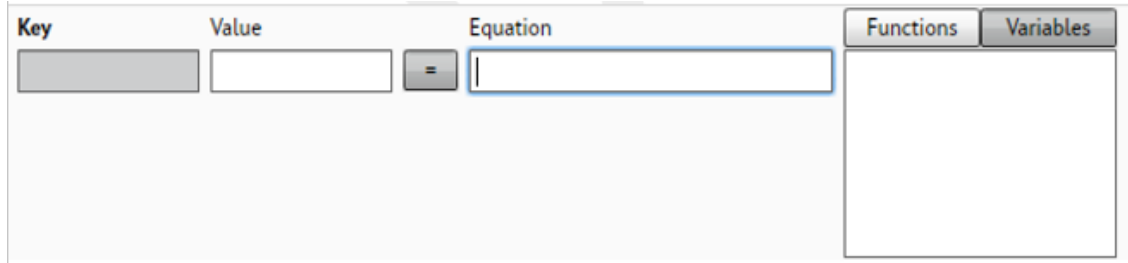
Figure 3. The metadata input boxes in the FMV user interface.